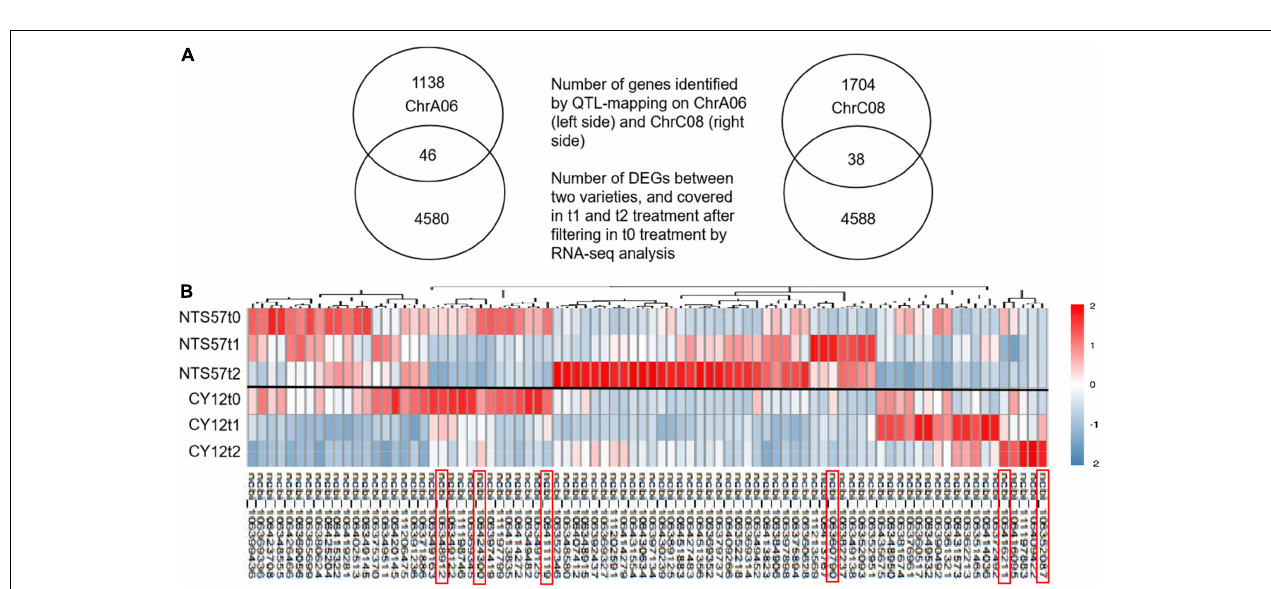
FIGURE 3 | Gene expression profiles and the differentially expressed genes (DEGs) identified between early- and late-flowering genotypes. The Venn diagram shows the numbers of upregulated (A) and downregulated (B) DEGs between two varieties with the different flowering times under three temperature treatments and the number of overlaps. The number of DEGs is shown in (C) .